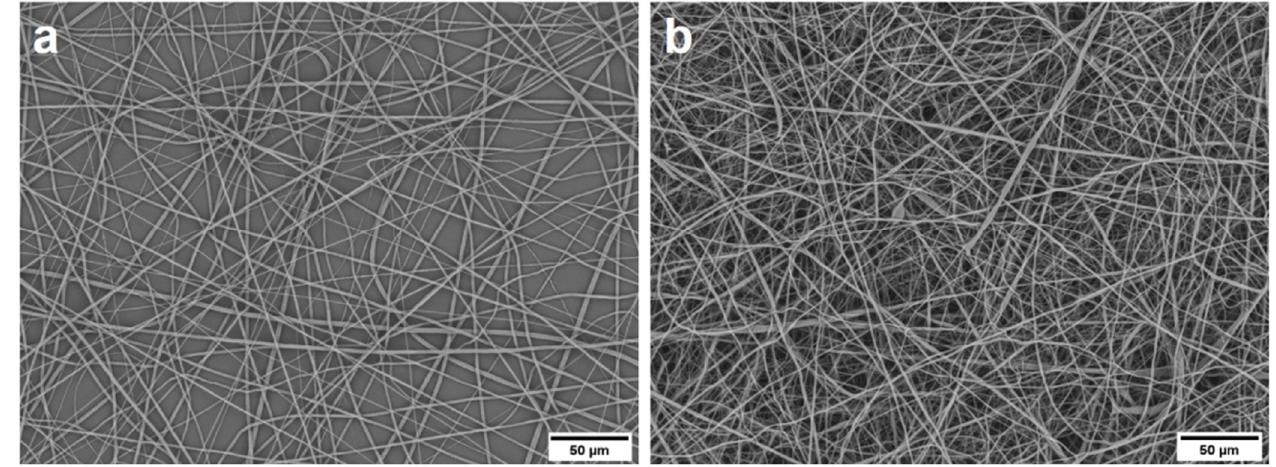
Figure 3. SEM images of the uncoated PCL fiber scaffolds with 700 nm fiber size in diameter of ( a ) the 24-well plate and ( b ) the loose PCL tissue.